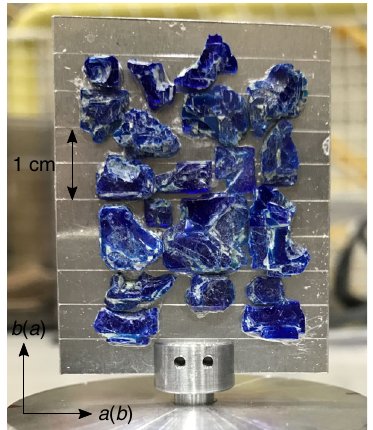
Fig. 6 Aluminum plate. Ba 2 CuSi 2 O 6 Cl 2 crystals co-aligned on an aluminum